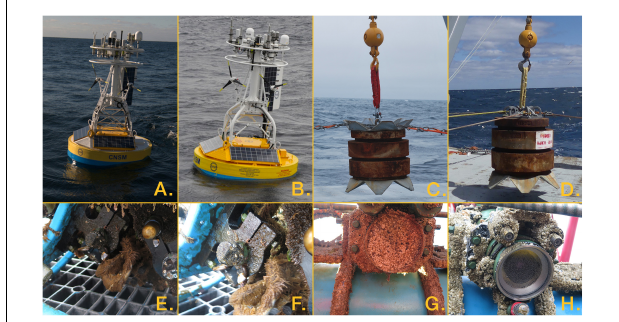
FIGURE 2 | Examples of equipment modifications. Enhancements in Surface Buoy tower modifications from (A,B) include, rearranging halo components to move telemetry sensors down and wind sensors up; replacing flat tower legs with tubular legs to prevent torsion; widening of vane to improve ability of buoy to point toward the wind. Updates to the Coastal Profiler Mooring Anchor design (C,D) to include top plate with multiple bales for recovery by ROV and safer handling on deck. Pre- and Post-biofouling mitigation photos on oxygen optodes (E,F) and cameras (G,H) on the Endurance Array. Credits: (A–D) WHOI; (E,H)